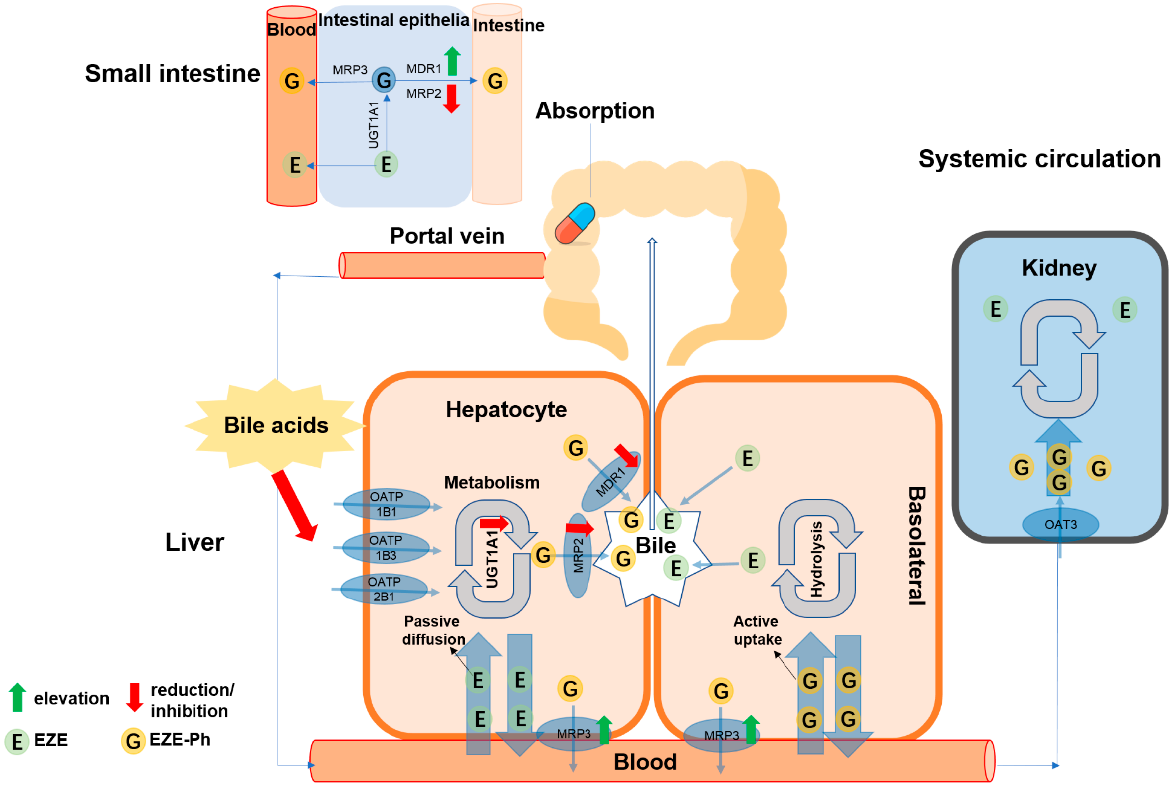
Figure 14. The in vivo pharmacokinetics of EZE, its major metabolites, and the proposed mechanism of the effects of hepatic impairment on these circulating compounds.